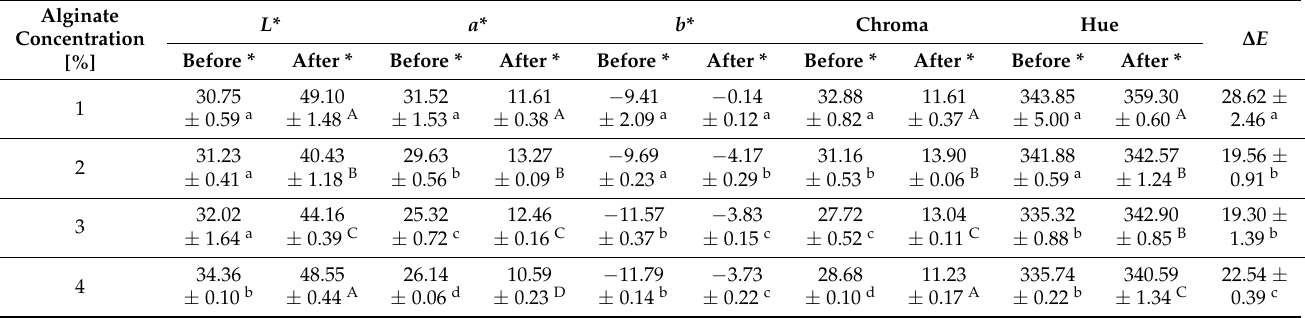
Table 2. Color parameters of the beads before and after desorption. Different letters (a,b,c,A,B,C) in the superscript in the same column represent significant differences at p < 0.05. (*—all samples before and after desorption were statistically significantly different at p <